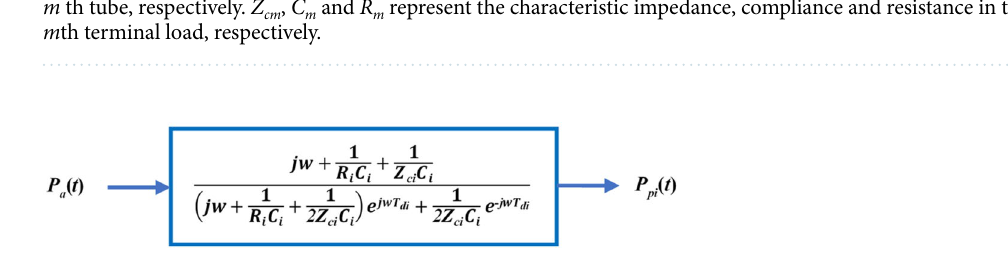
Figure 7. The transfer function between the aortic and peripheral pressure